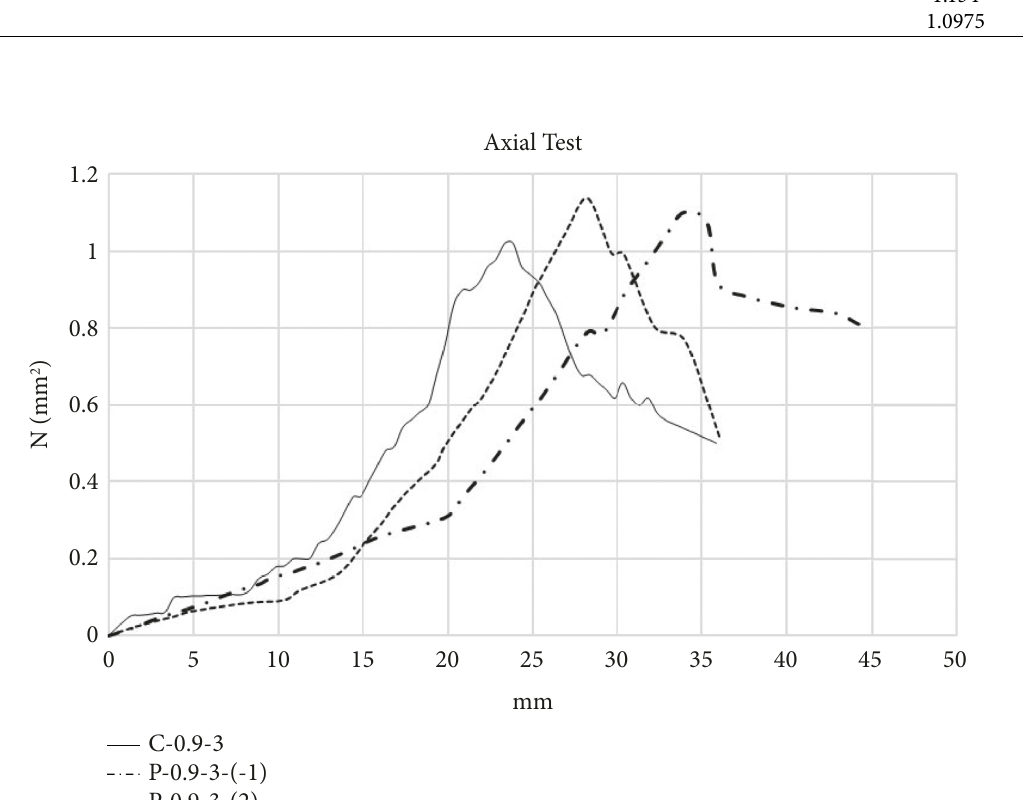
Figure 11: The comparison of the axial test results between fire-resistance polyurethane foam panels and C-0.9-3 type of foamed concrete